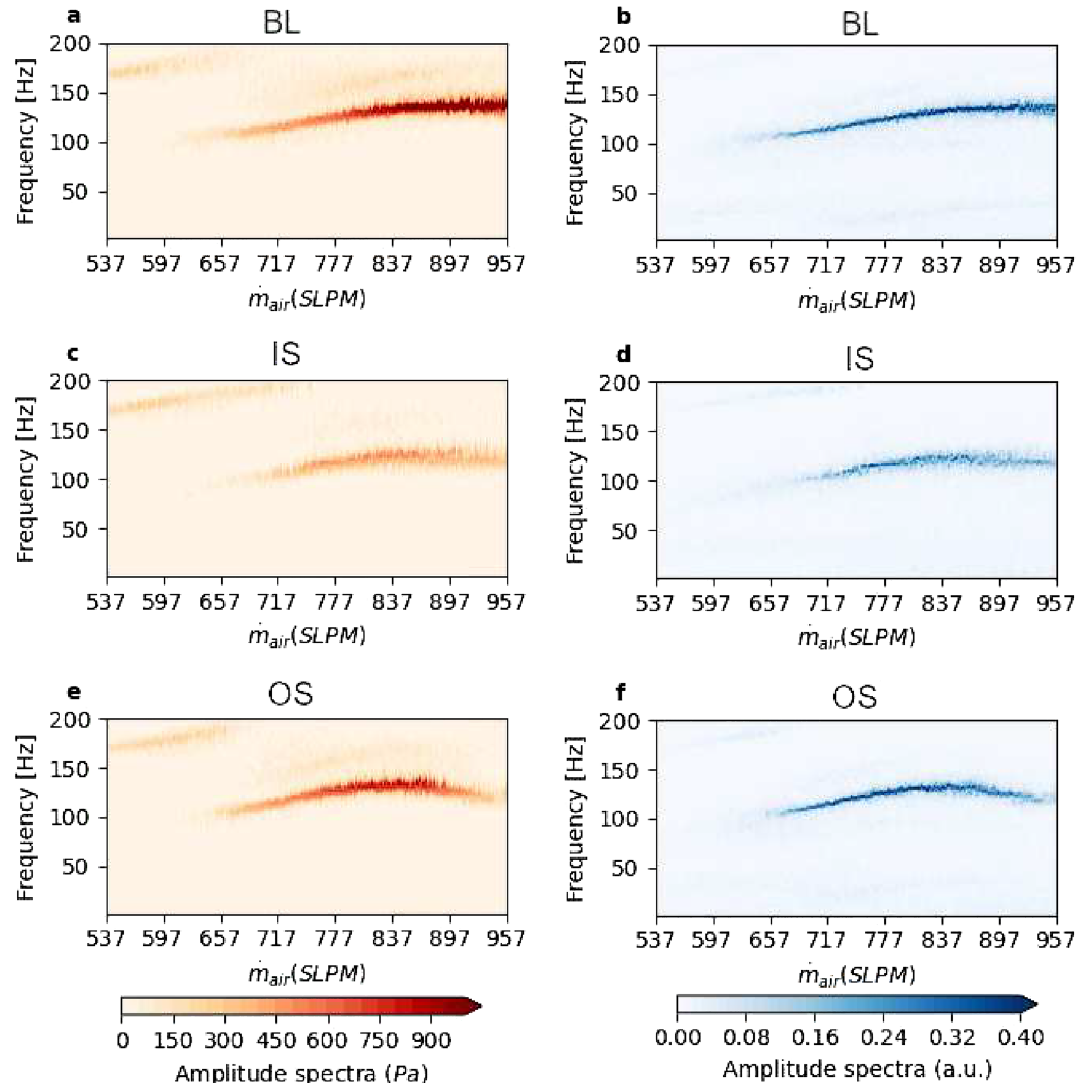
the slots, additional dominant frequencies do not emerge in comparison to